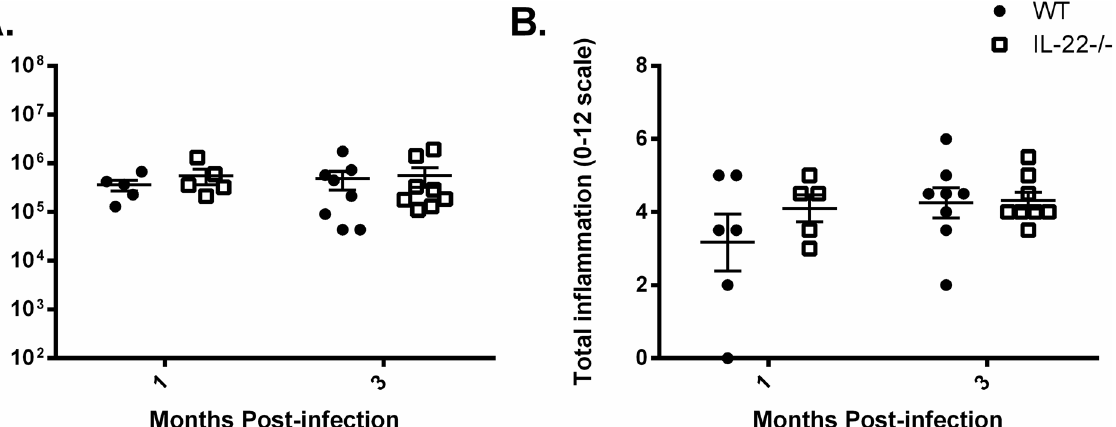
Fig 4. IL-22 is not required to control bacterial burden or gastric inflammation in the mouse model. (A) Bacterial burden was measured in WT and IL- 22-/- mice that were infected with PMSS1 for 1 month or 3 months. Colony forming units (CFU) per gram of stomach tissues was calculated and is presented in the graph. (B) Levels of acute and chronic inflammation were scored on stomach tissue (in the corpus and antrum) at 1 month and 3 months post infection with strain PMSS1. Total inflammation as presented is the sum of acute and chronic inflammation. Statistical analysis was performed using Mann-Whitney U which resulted in no significant differences between the groups, and error bars represented mean ± SEM. See methods for scoring system (scale is 0 – 12).